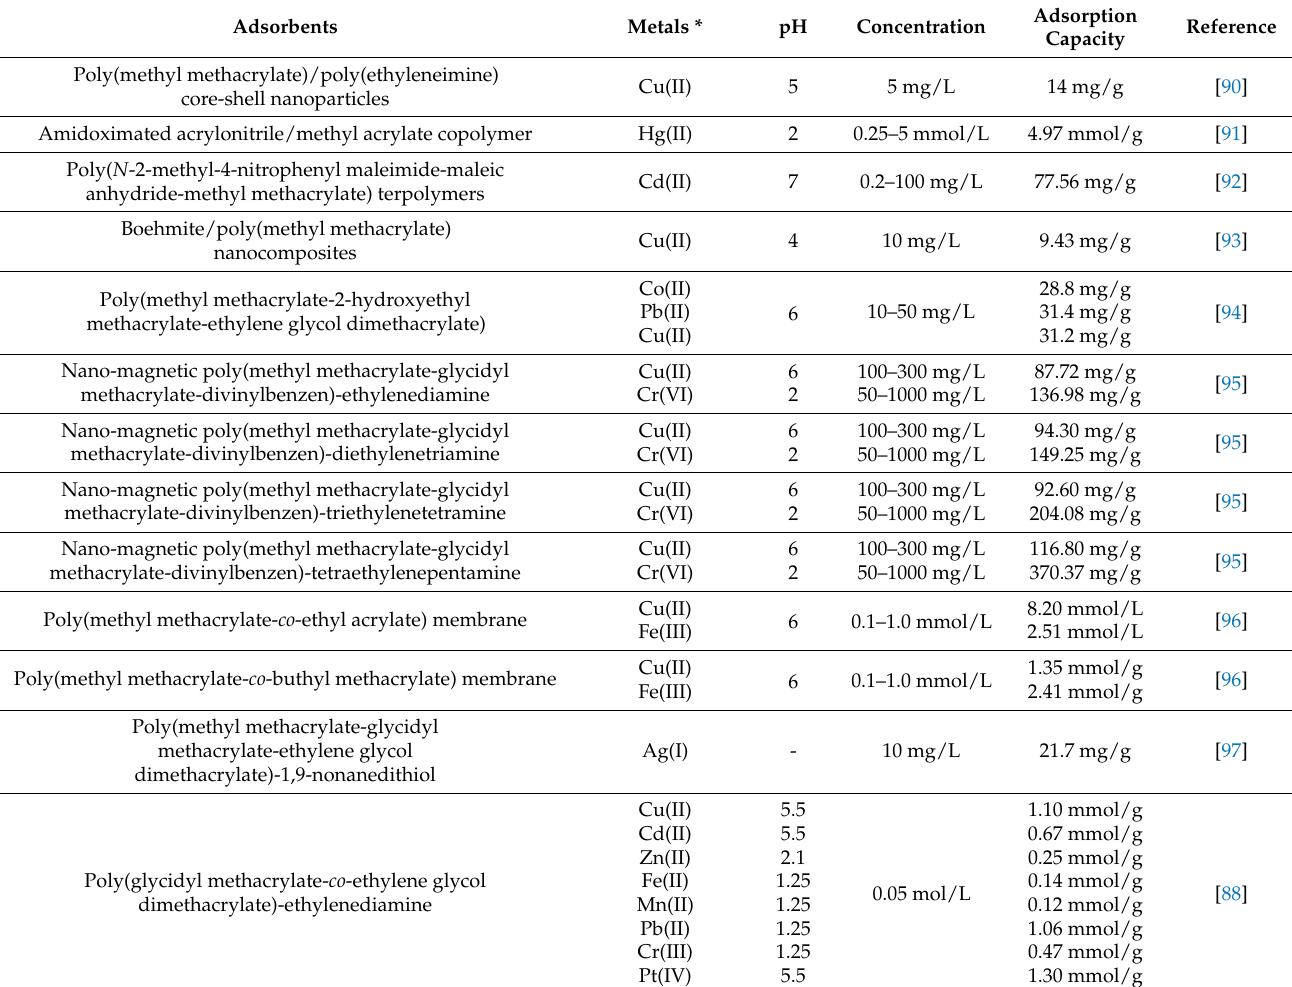
Table 3. Adsorption capacity of metal ions using different methacrylate